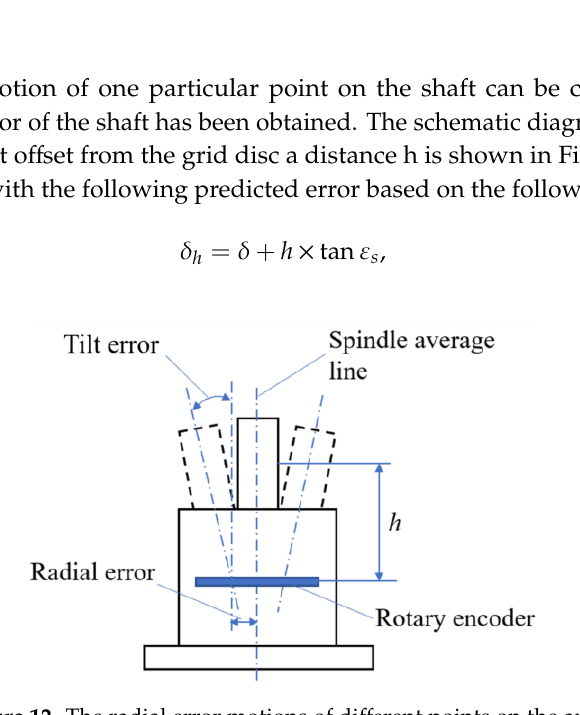
Figure 12. The radial error motions of different points on the axis.